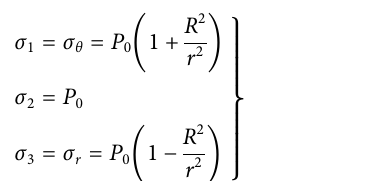
indoor test results in Figure 4 , but the simulation result of the damage zone is the same as the fi eld test result.